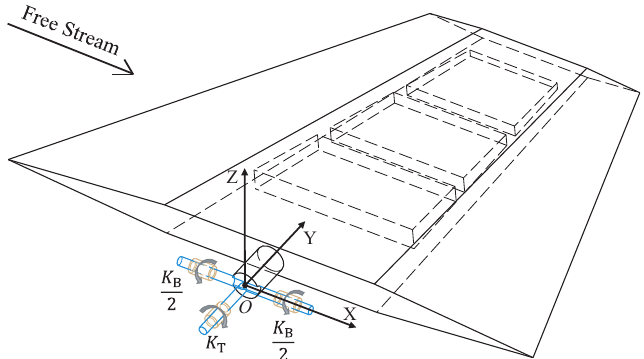
Figure 1. Simplified model of the all-movable fin examined in this